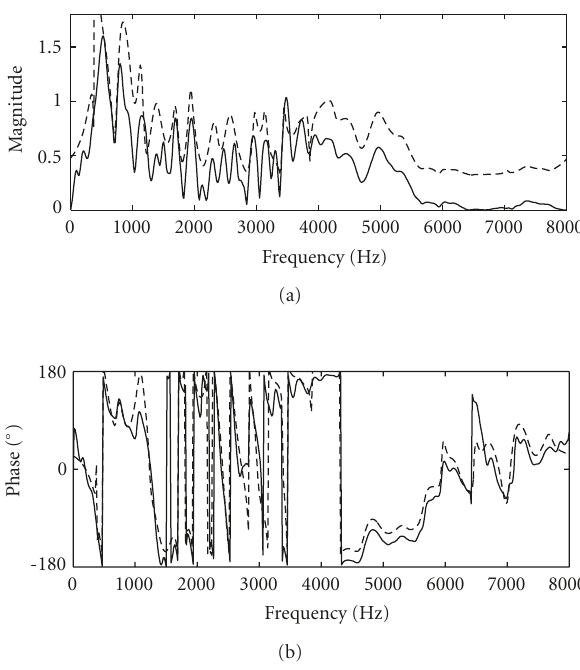
Figure 8: Case (C-1): (a) magnitude and (b) phase of ATF from demigration (solid line) and its model with N = 31 (dashed line). Magnitude and phase of model have an o ff set for better compara- bility.